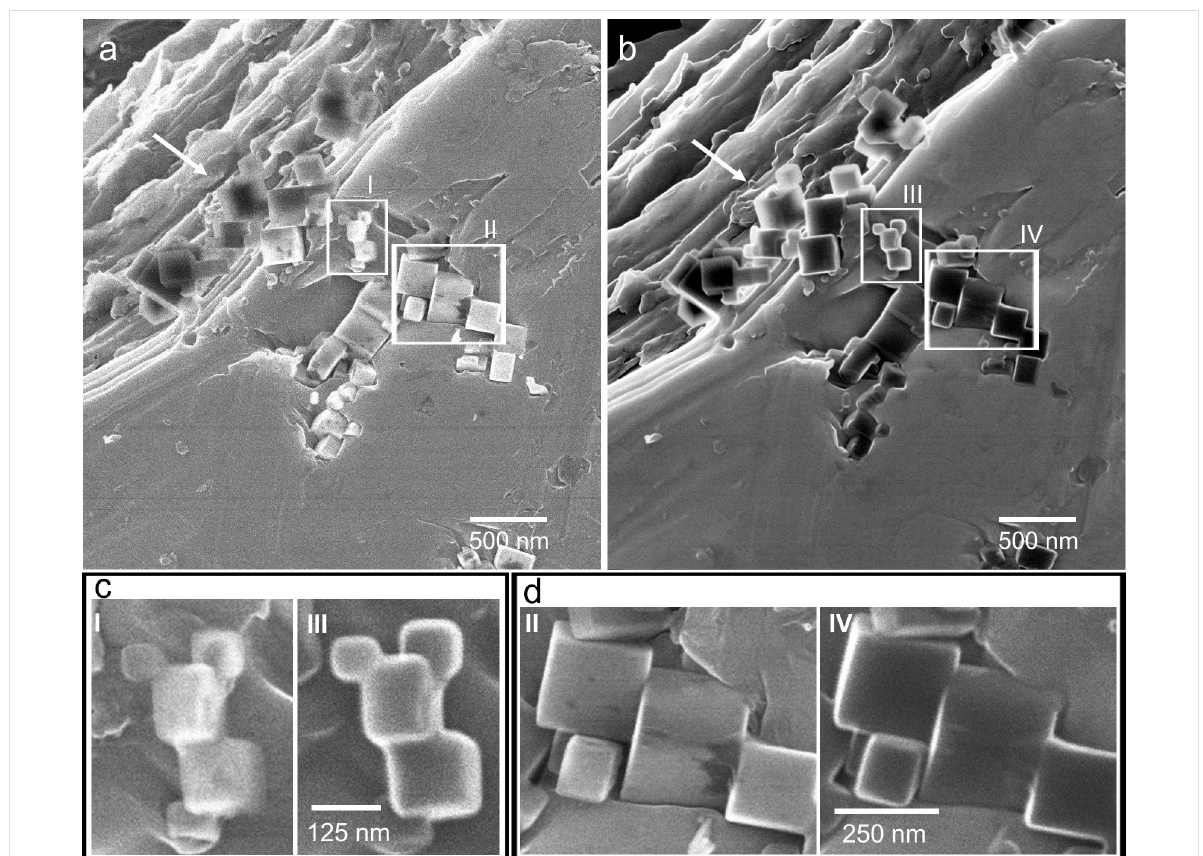
Figure 4: In addition to morphological changes under high-vacuum conditions, the MgO cubes embedded in the as-received indium foil after (a) 1 h and (b) 4 days in the HIM chamber (chamber pressure p < 3·10 − 7 mbar) exhibit contrast changes, which are attributed to the surface chemistry. MgO cubes that are not in contact with the indium foil (marked by arrows) do not exhibit any changes. (c,d) MgO cubes in areas I–IV at higher magnifica- tion illustrating both morphological and contrast changes. (HIM SE images recorded at 30 kV acceleration voltage and (a,b) 0.3 pA beam current, 5·10 14 cm − 2 ion dose, (c,d) 0.3 pA beam current, 2·10 15 cm − 2 ion